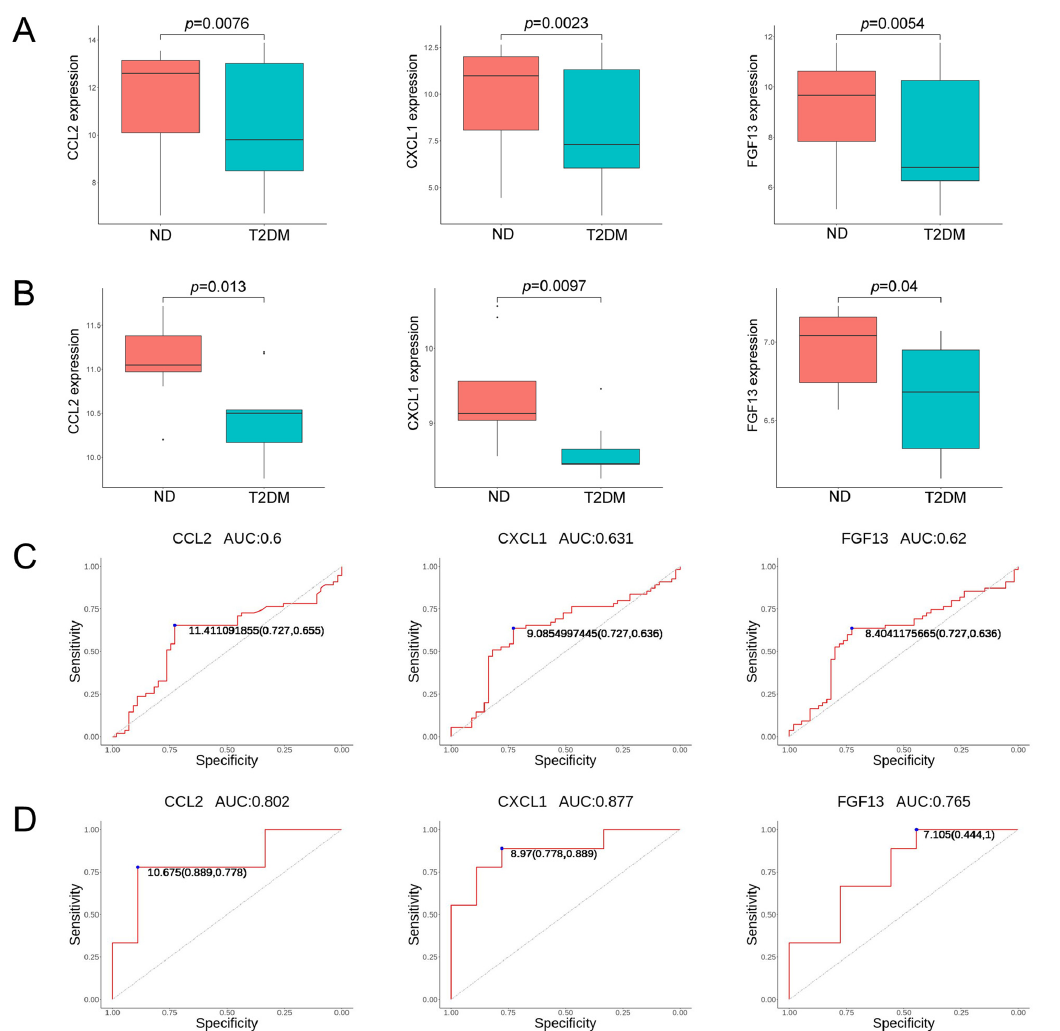
Figure 5. Validation of hub genes: ( A , B ) The expression of hub genes (including CCL2, CXCL1, and FGF13) detected in GSE76896 and GSE38642; and ( C , D ) ROC curves of the selected genes in GSE76896 and GSE38642.